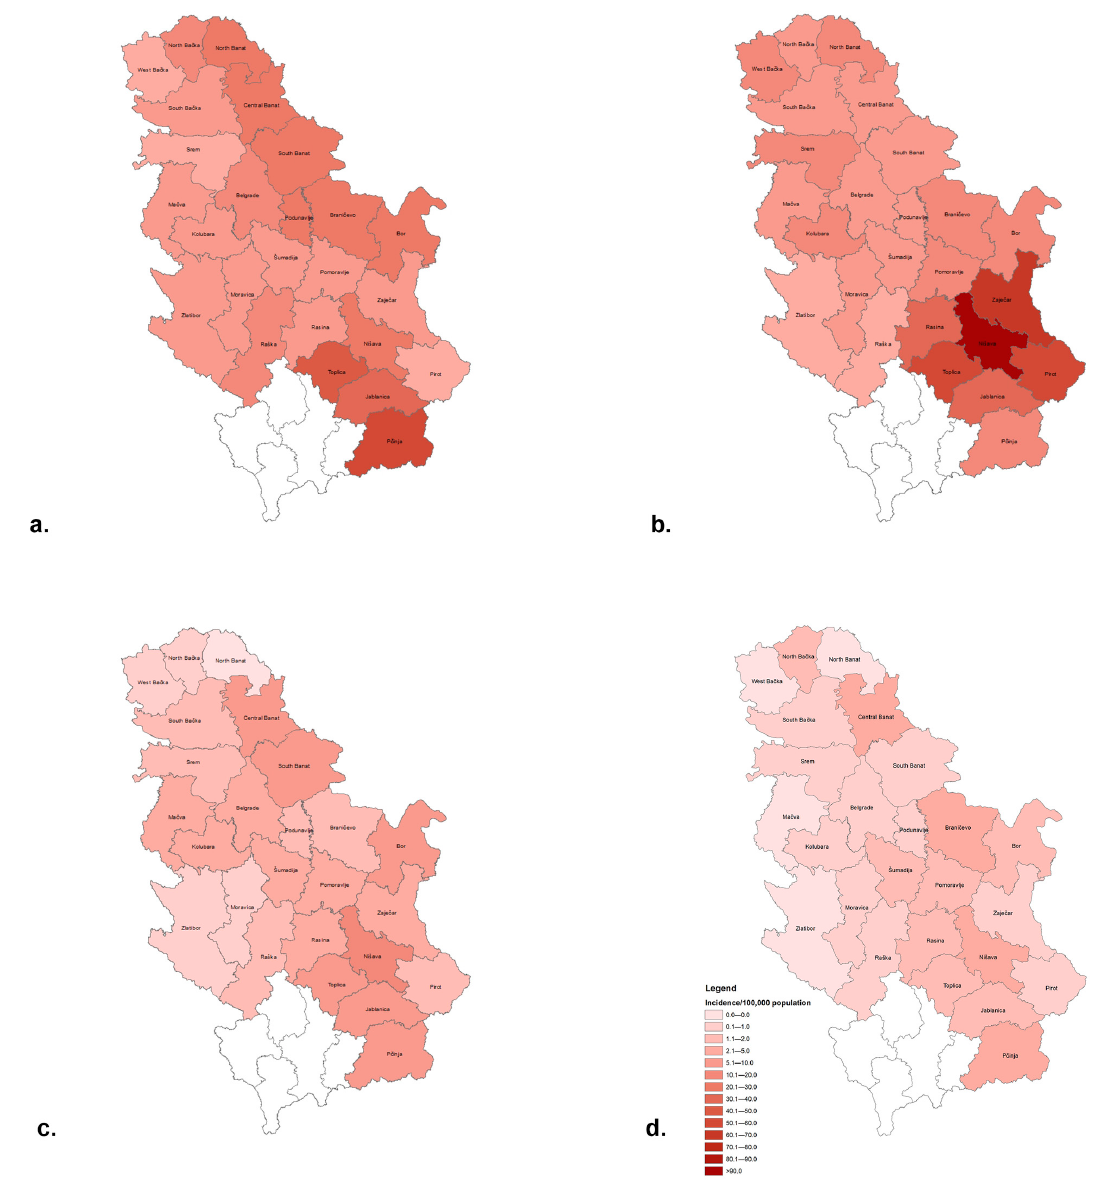
Figure 3. Average district-level incidence rates of hepatitis A in the subperiods ( a ) 2002 – 2006, ( b ) 2007 – 2011, ( c ) 2012 – 2016, and ( d ) 2017 – 2021.